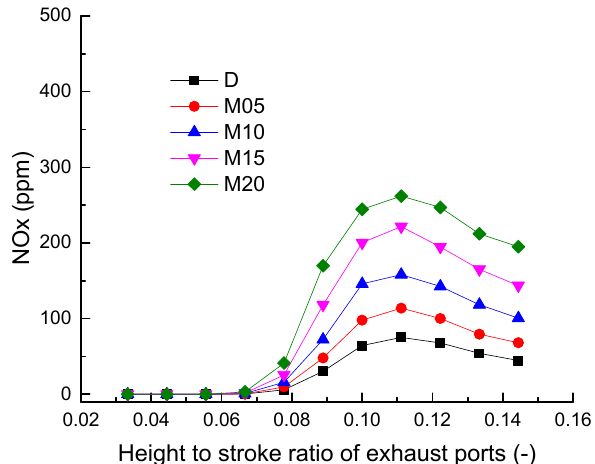
Figure 9. NOx under different HSRs of exhaust ports.